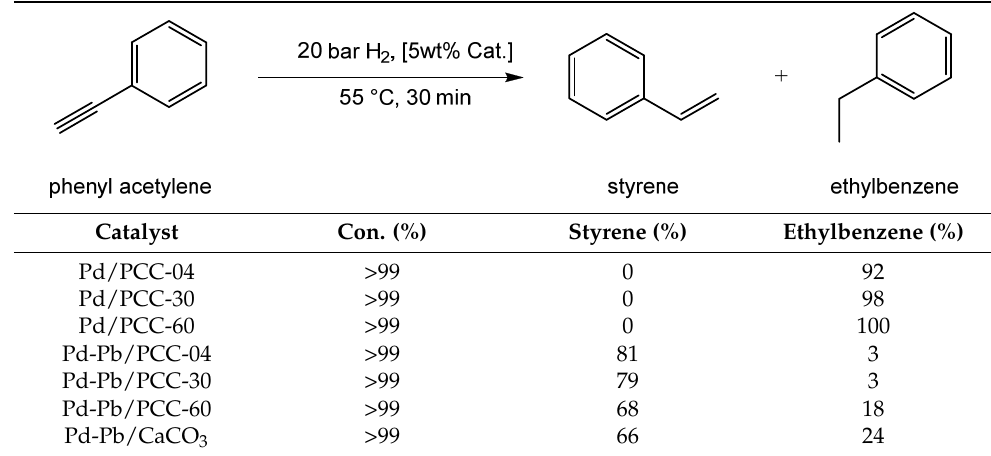
Figure 4. X-ray photoelectron spectroscopy (XPS) profile of Pd 3d on 5 wt% Pd-Pb/ PCC-04, 5 wt% Pd-Pb/PCC-60, and commercial 5 wt% Pd-Pb/CaCO 3 . We refer to Figures S13–S15 for additional characterization data. Table 2. Catalysts screening with phenylacetylene as a model substrate a .